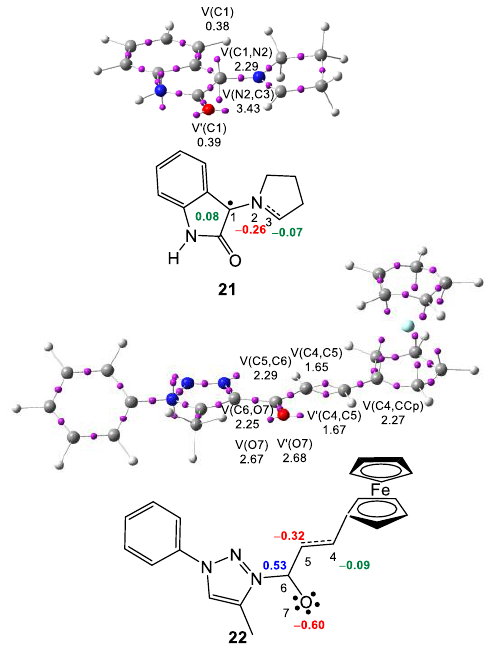
Figure 1. ω B97X-D/6-311G(d,p) ELF basin attractor positions together with the most relevant valence basin populations and ELF-based Lewis-like structures together with natural atomic charges of AY 21 and ferrocene ethylene 22 . Valence basin populations and natural atomic charges are given in average number of electrons, e. Negative charges are colored in red, positive charges in blue, and negligible charges in green.